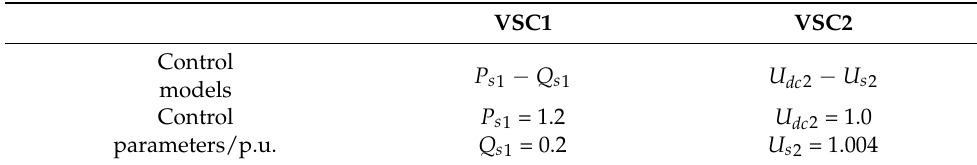
Figure 10. The new topology of the interconnected power grid. Table 3. The parameter setting of the converter stations.